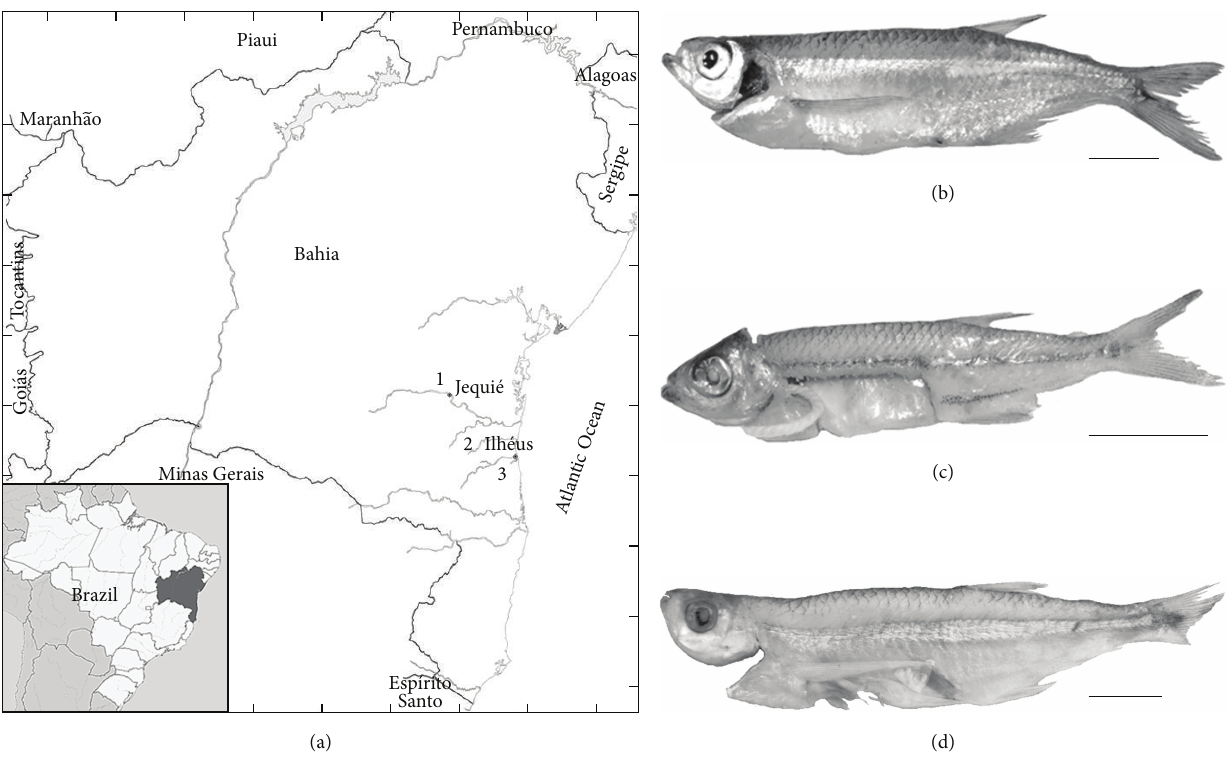
Figure 1: Map of the state of Bahia in northeastern Brazil (a), indicating the three collection sites (1: Contas River, 2: Almada River, and 3: Cachoeira River) of Lignobrycon myersi . On the right, photographs of fresh (b), frozen (c), and salt-conserved (d) specimens of L. myersi (the bar equals